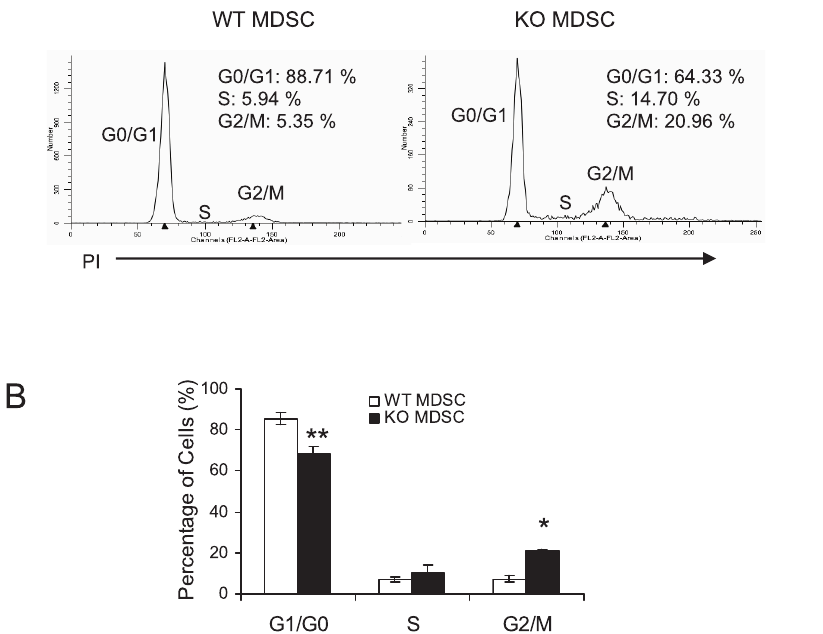
Figure 3. Cell cycle analysis of lal 2 / 2 bone marrow MDSCs. A ). Cell cycle analysis of CD11b + ly6G + MDSCs from the bone marrow of lal + / + mice and lal 2 / 2 mice; B ). The G1/G0 phase, S phase and G2/M phase of CD11b + Ly6G + MDSCs from the bone marrow of lal + / + mice and lal 2 / 2 mice were statistically analyzed. Results are means of 4 independent FACS experiments. n=4, **, p , 0.01, *, p , 0.5.